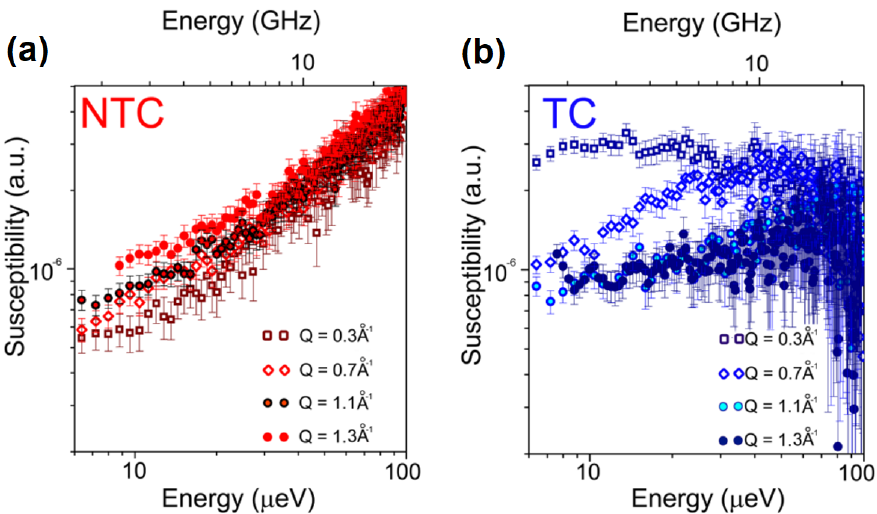
Figure 7. Dynamic susceptibilities obtained from QENS data for not-treated breast cancer cells (MCF-7), NTC ( a ), and breast cancer cells treated with 15nM of paclitaxel for 24 h, TC ( b ), reprinted from [16] available via the Creative Commons Attribution 4.0 International License (CCBY4.0, https://creativecommons.org/licenses/by/4.0/, 29 March 2022).